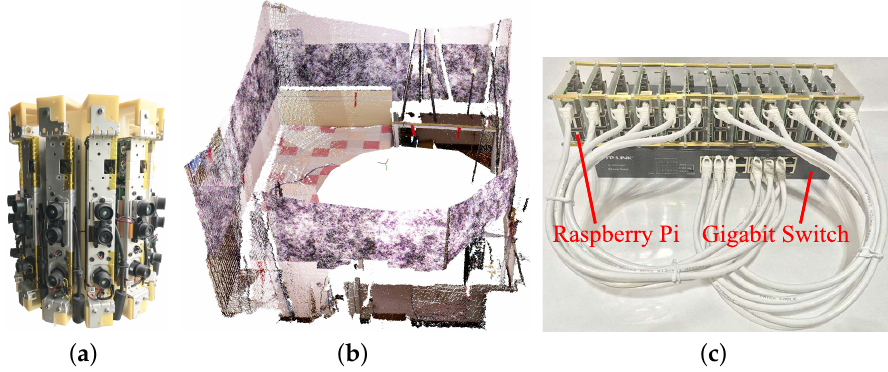
Figure 2. ( a ) The setup used in this study for evaluating the proposed calibration method composed of 12 Kinect v1 RGB-D cameras. ( b ) The panoramic 3D color point cloud obtained by the panoramic 3D vision system. Descriptor-based calibration patterns are pasted on the walls to calibrate multiple RGB-D cameras. ( c ) Distributed capturing system consisting of a gigabit switch and 12 low-cost Raspberry Pi single board